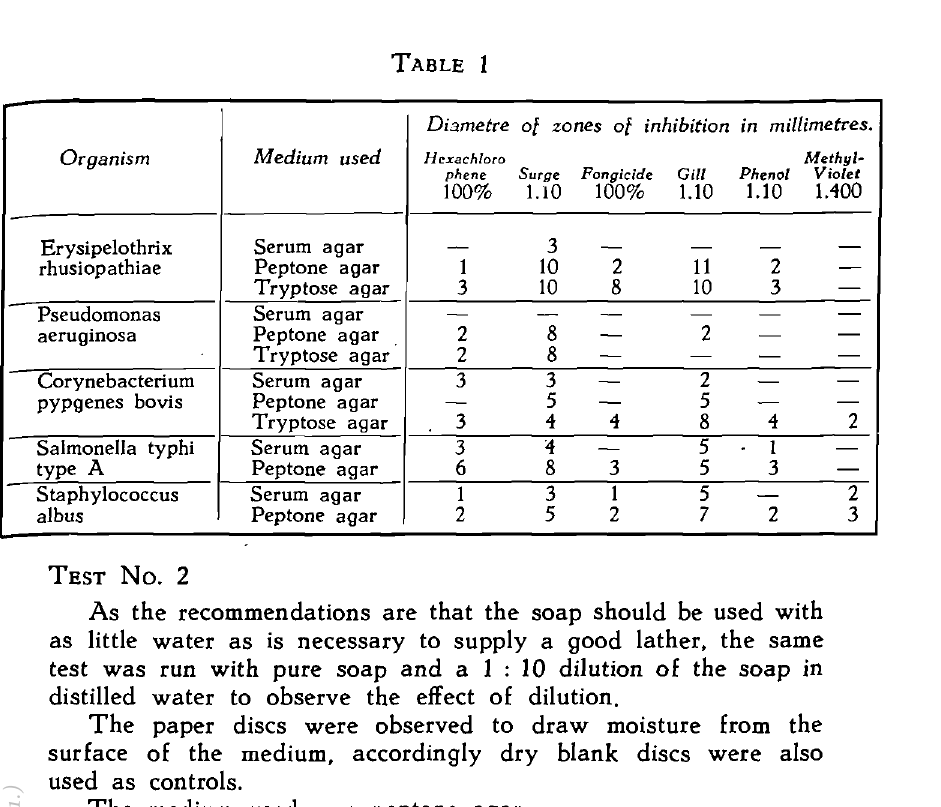
Diameter of Zone of Inhibition in